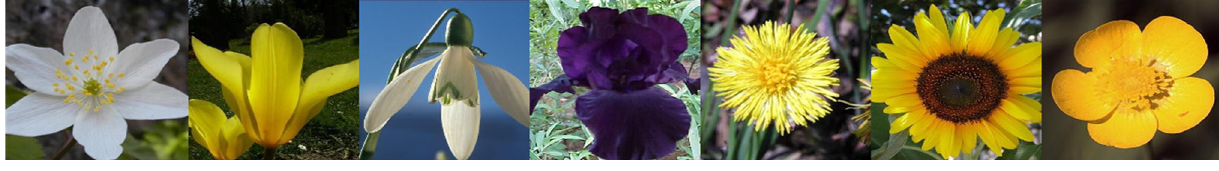
Fig. 8. 17 Flower dataset images